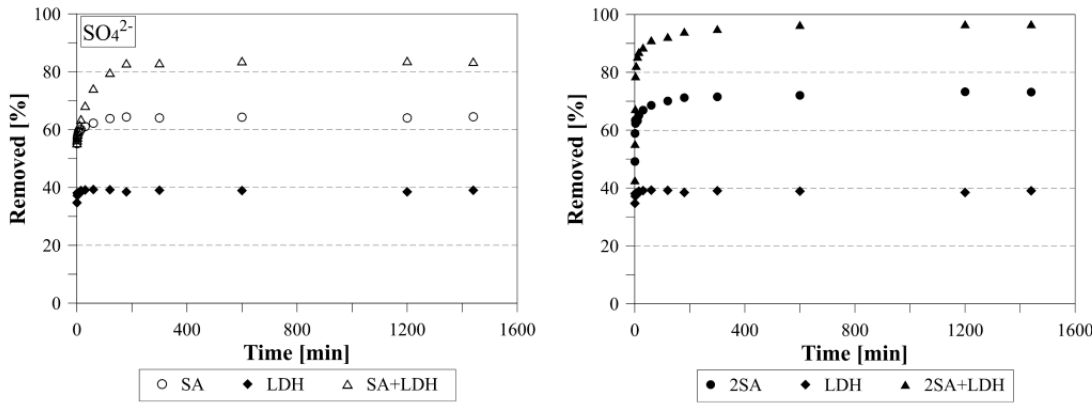
Figure 11. The kinetics of sulfate removal.